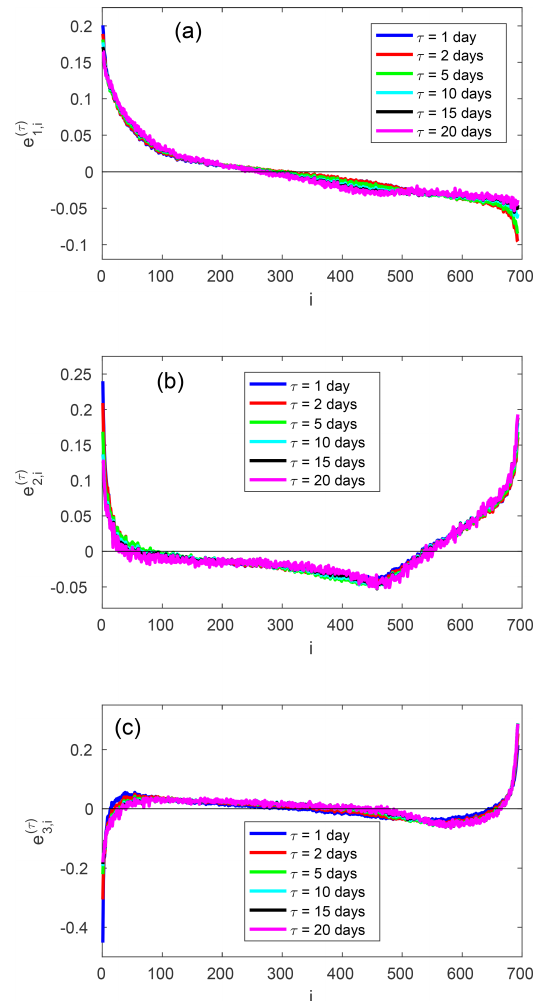
Figure 4. (a) First, (b) second and (c) third normalized empirical orthogonal function (EOF) of the finite-time Lyapunov fluctuations (cf., Eq. 20).